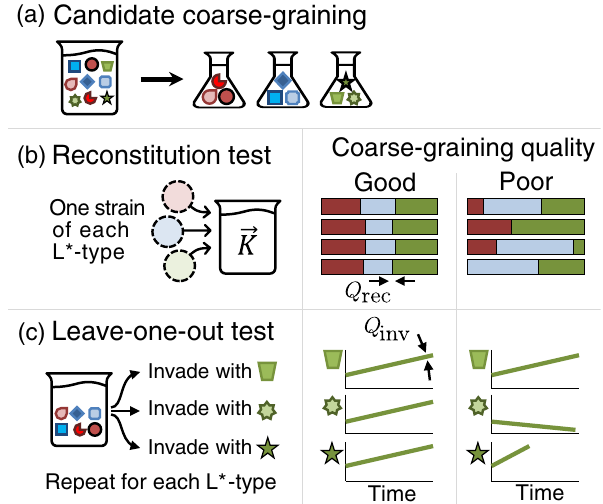
FIG. 4. Specific criteria for assessing coarse-graining quality Q ð L; L (cid:3) Þ . (a) In this cartoon, the community is coarse-grained into three operational taxonomic units (OTUs), implemented in our model as L (cid:3) -types. (b) The reconstitution test. Under this criterion, grouping strains into coarse-grained OTUs is justified if reconstituting a community from a single representative of each OTU yields similar communities regardless of which represent- atives we pick. As a quantitative measure, we compare the OTU abundances across replicates. (c) The “ leave-one-out test. ” Under this criterion, grouping strains into coarse-grained OTUs is justified if the strains constituting OTU X (green in this cartoon) all behave similarly when introduced into a community missing X . As a quantitative measure, we compare the invasion rates of the left-out